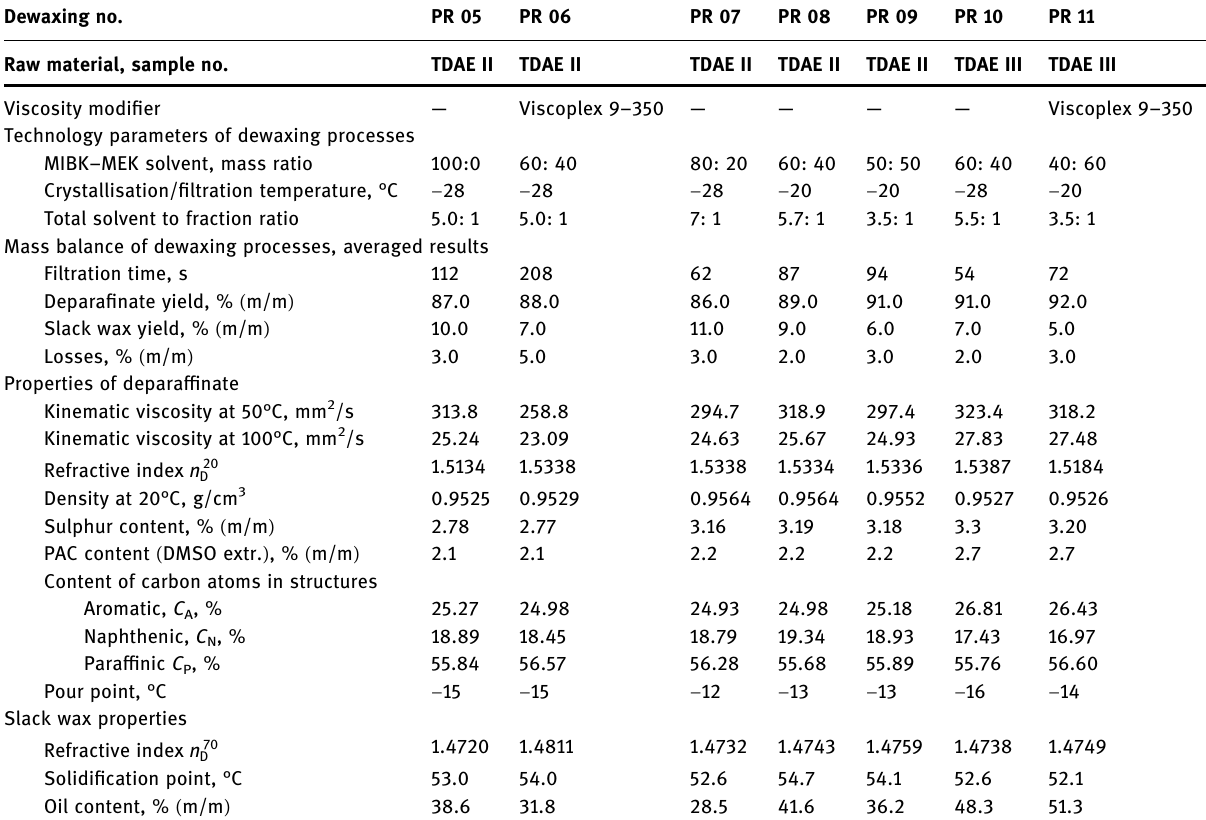
Table 5: Technology parameters, mass balance and properties of the obtained depara ffi nates and slack waxes, in MIBK – MEK dewaxing processes of TDAE II and TDAE III raw material samples Dewaxing